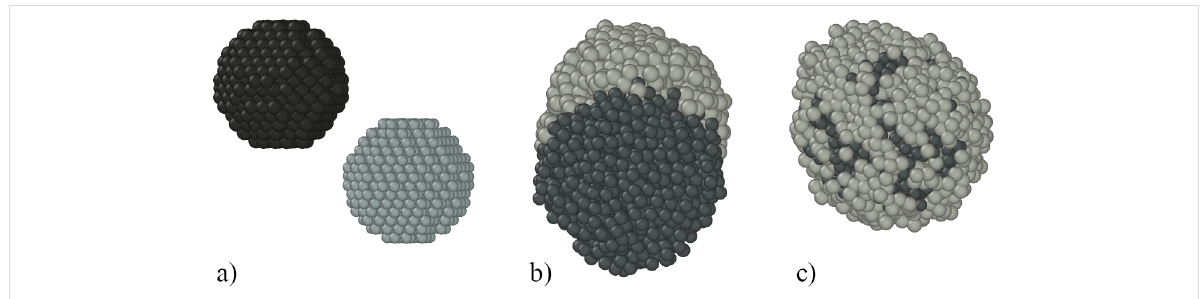
Figure 4: Changes in the structure of the nanocluster in time: a) initial state; b) intermediate Janus-like structure; c) core–shell structure.